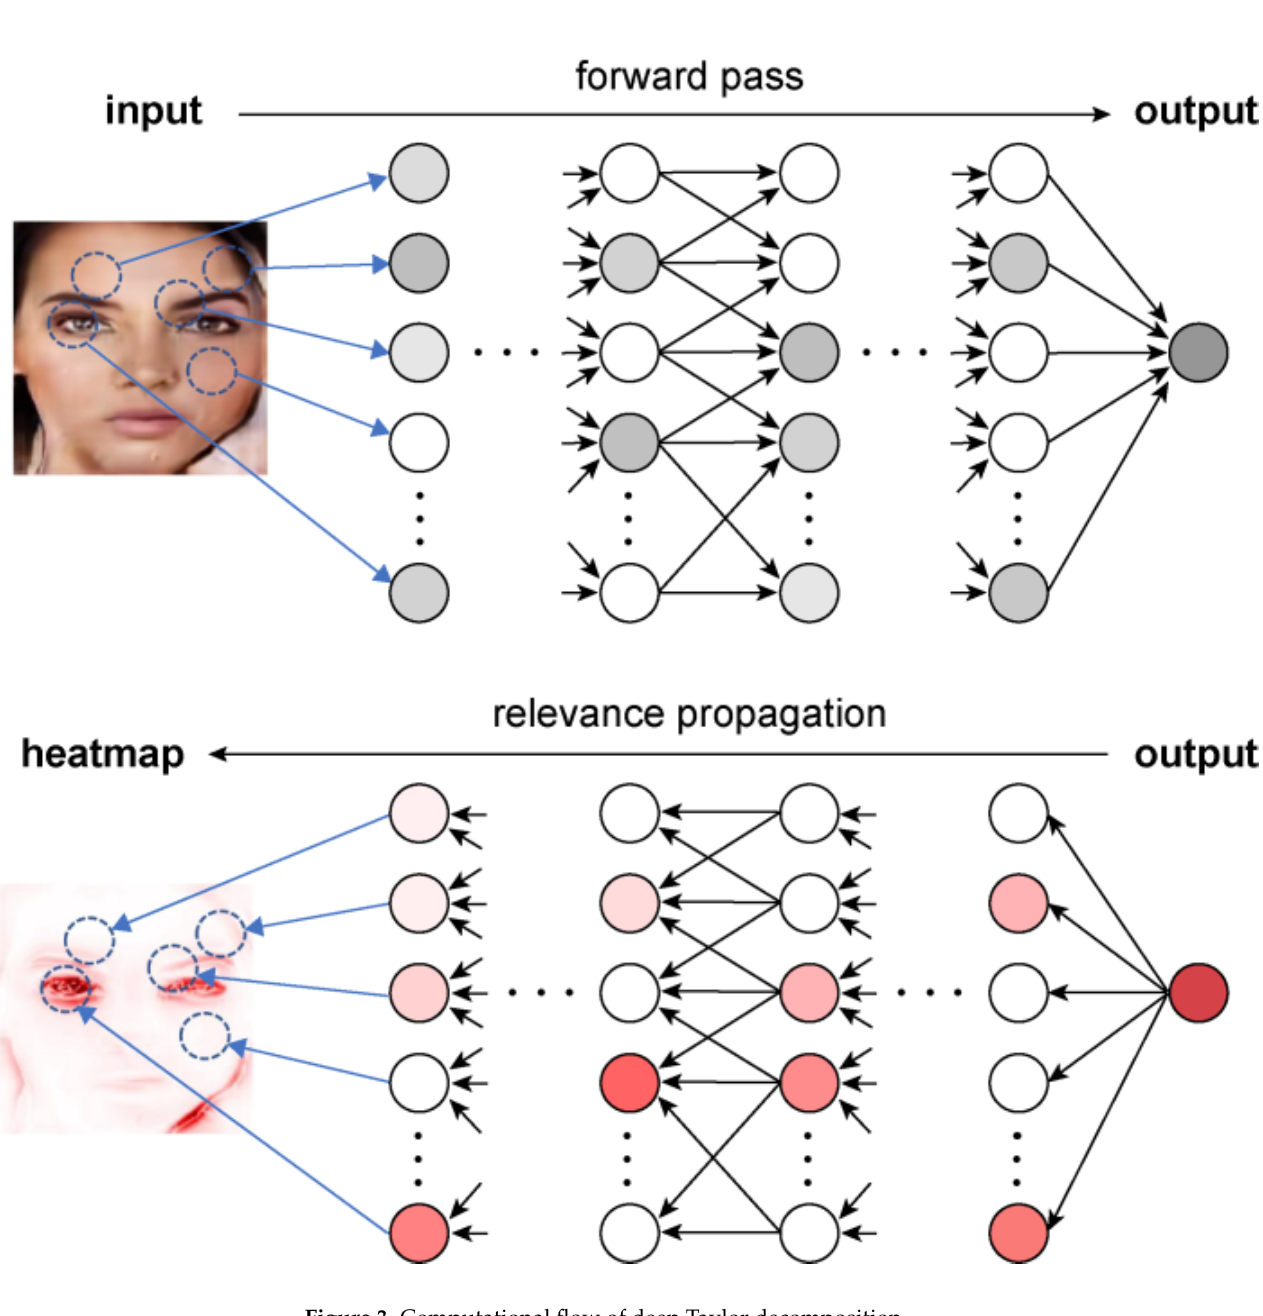
Figure 3. Computational flow of deep Taylor decomposition.